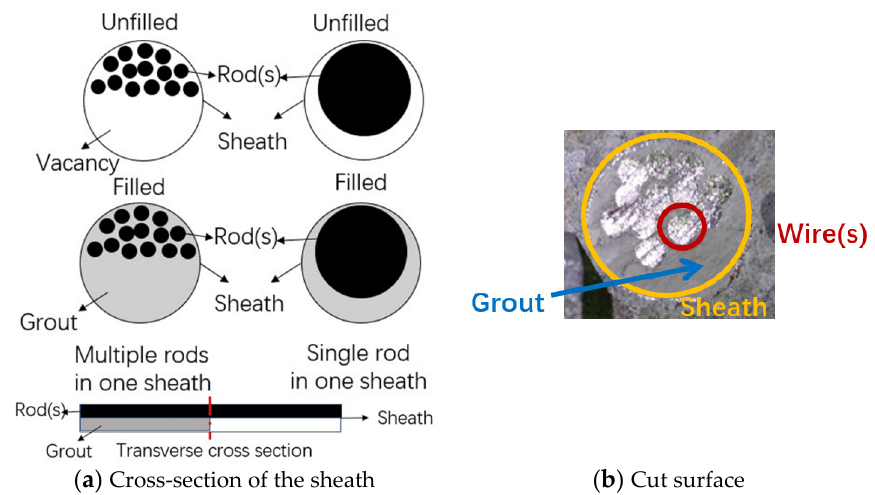
Figure 7. ( a ) Schematic of the cross-section of a sheath; ( b ) cut surface of a sheath.